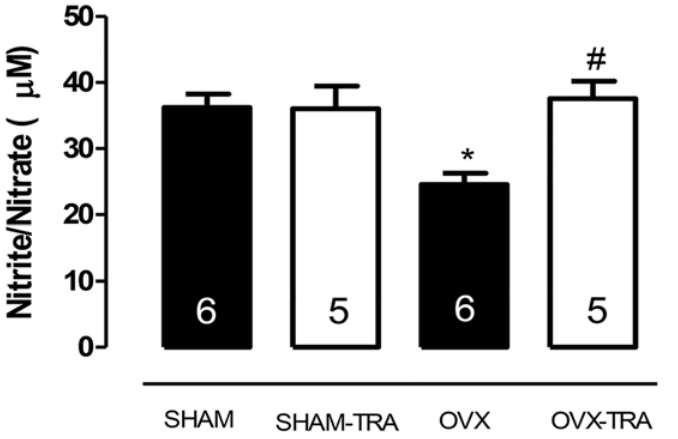
Fig 3. Nitrite/nitrate plasma levels from SHAM, SHAM-TRA, OVX and OVX-TRA rats. Results are expressed as means ± SEM. The numbers shown in bars represent the number of animals analyzed in each group. Two-way ANOVA: * p < 0.01 in comparison to SHAM, # p < 0.01 in comparison to OVX.